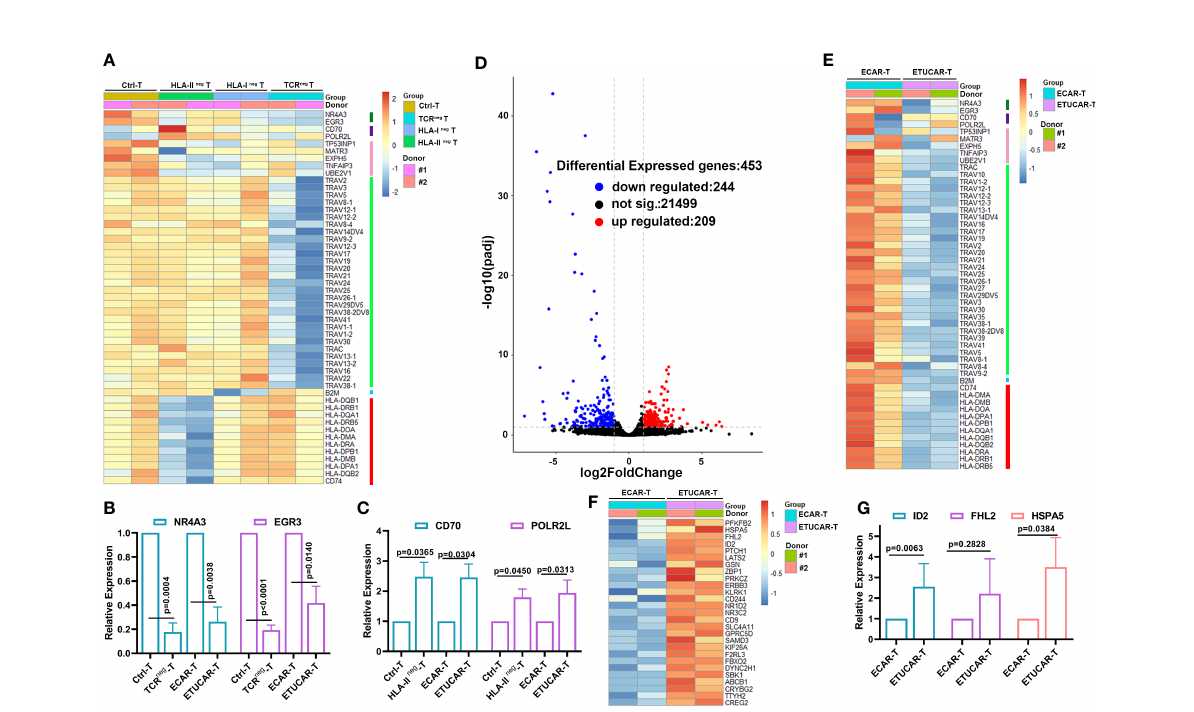
FIGURE 6 Poor ef fi cacy of ETUCAR-T cells is associated with a unique transcriptional pro fi le. (A) , Differential expression gene among Ctrl-T cell transduction with Cas9 protein, TCR neg T, HLA-I neg T, and HLA-II neg T cells was analyzed by RNA sequencing. Heat map of differential expression gene between Ctrl-T and single-gene-de fi ciency T cells (n = 2). (B, C, G) , RT ‐ PCR results for analyzing the expression of representative differential expression genes in T cells (n = 3). (D) , Volcano diagram of differential expression genes of ETUCAR-T cells compared with unedited ECAR-T cells (n = 2). (E) , Downregulation expression genes between ECAR-T transduction with Cas9 protein and ETUCAR-T cells were analyzed by RNA sequencing (n = 2). (F) , Upregulation expression genes between ECAR-T transduction with Cas9 protein and ETUCAR-T cells were analyzed by RNA sequencing (n = 2). Data represent the mean ± SD. Statistical signi fi cance was determined with two-tailed, unpaired Student ’ s t -test. Cells were collected after being activated for 9 days. Differential gene entry criteria were (padj < 0.1 and abs (log2FoldChange) ≥